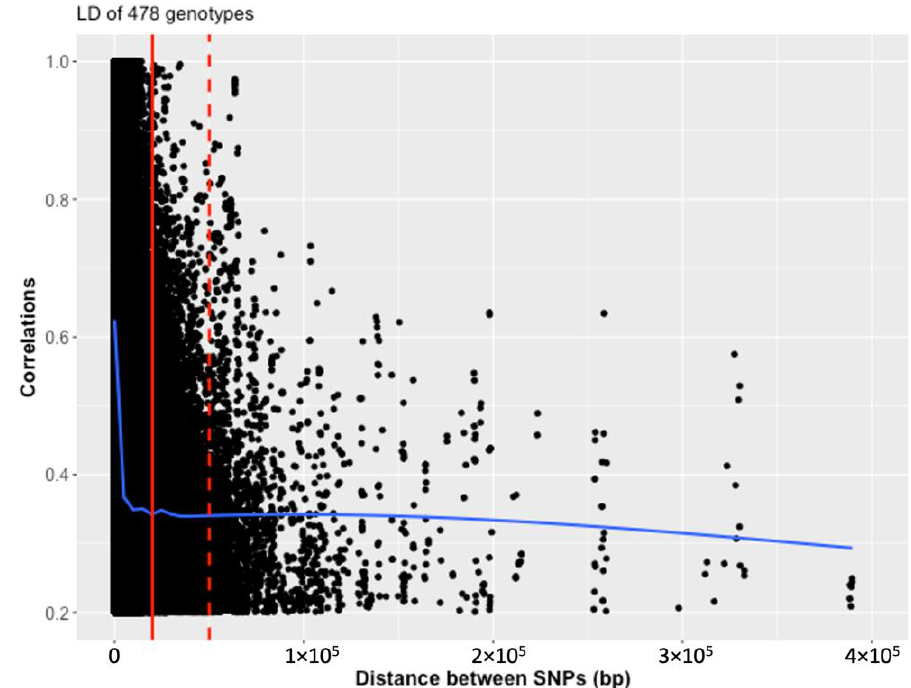
Figure 2. Scatter plot showing the linkage disequilibrium (LD) decay by plotting physical distance in base pairs against the LD estimate as correlations (R 2 ) in 478 genotypes. The LD (blue curve) decays rapidly within 20 kb (solid red line) and reaches background levels around 50 kb (dashed red line).